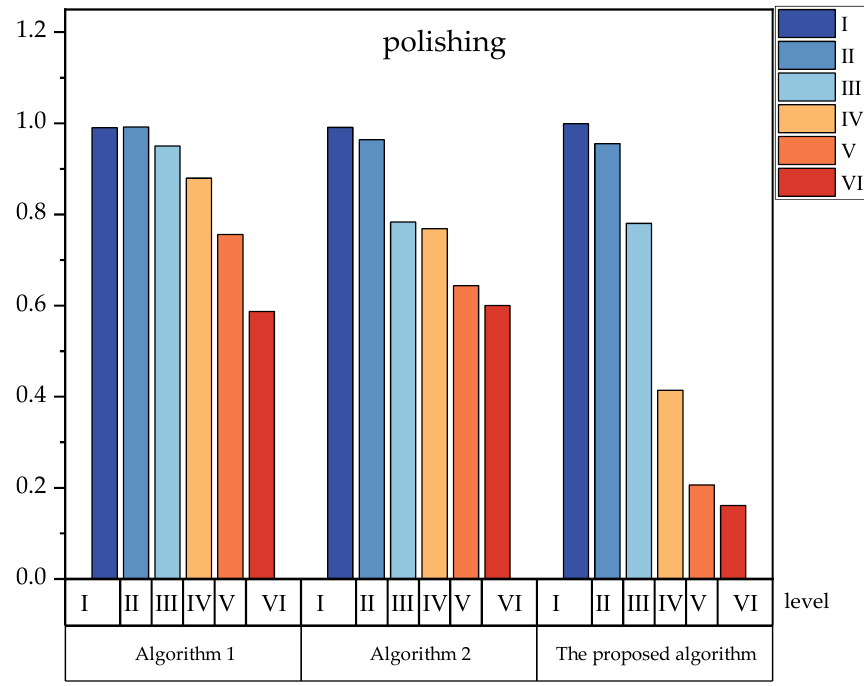
Figure 5. Histograms of the membership degrees of polishing.